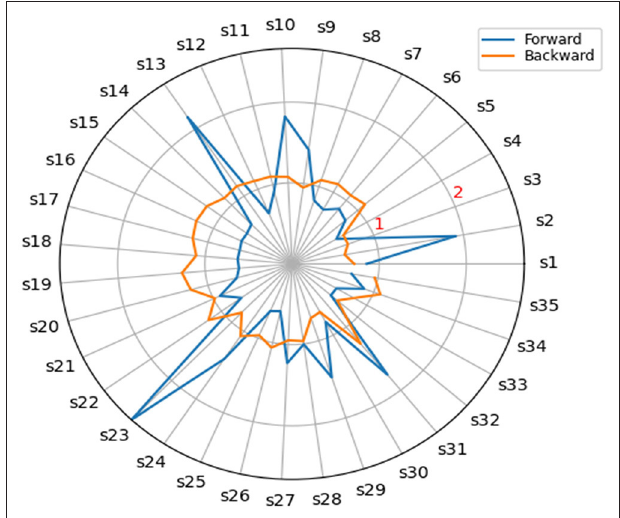
FIGURE 2 | Key sectors for Saudi Arabia 2018. TABLE 2 | Forward and backward coefficient of variation for four key sectors.